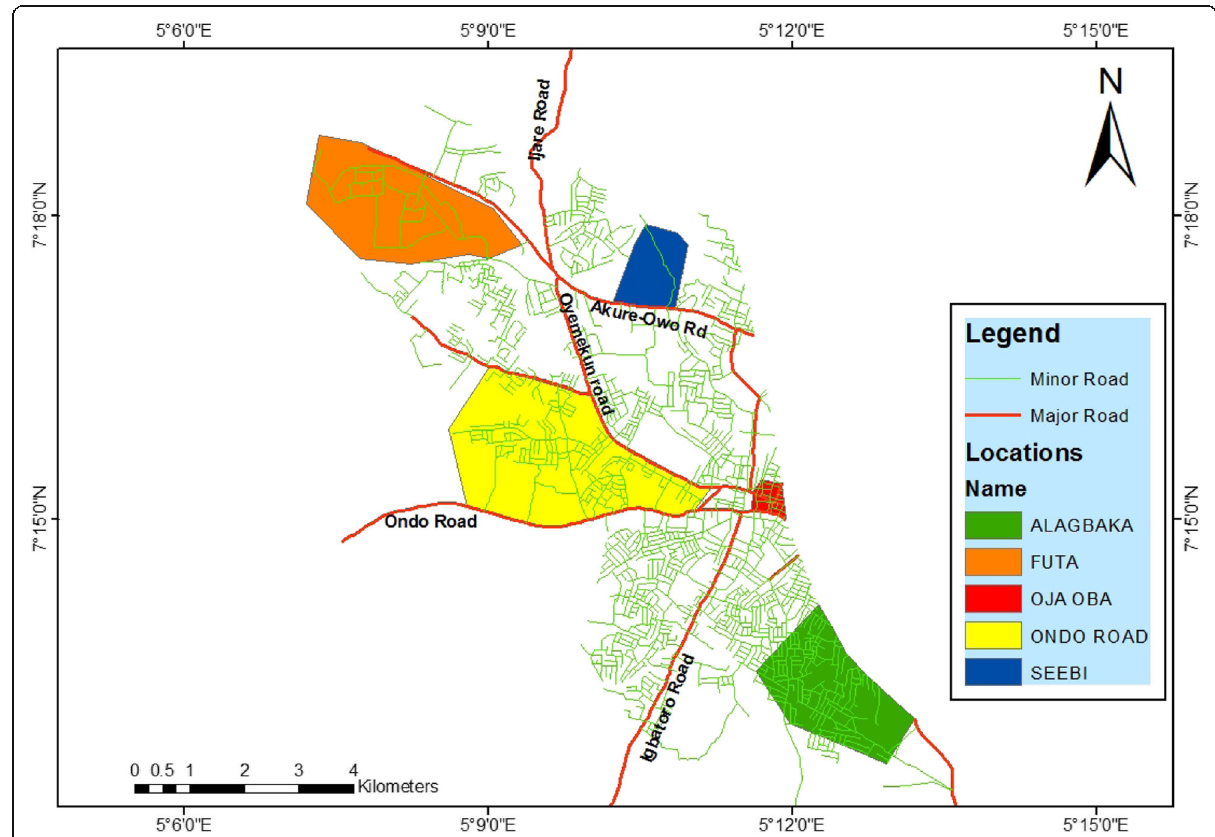
Fig. 1 Map of Akure South showing the sampled